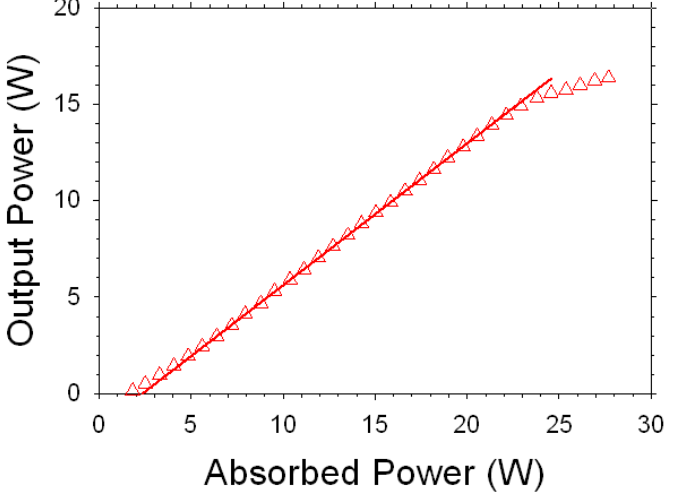
Figure 17. Output power versus absorbed power for a 10% Yb:Lu 5% output coupler. Pumping was with a diode operating at 975